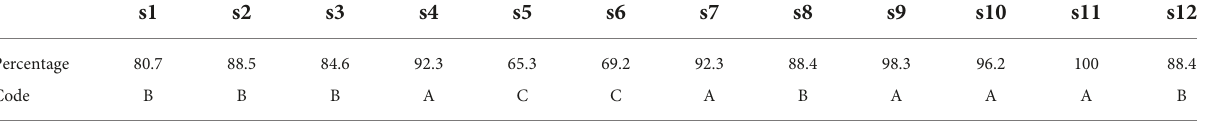
TABLE 6 Cognition of preservice mathematics teachers.